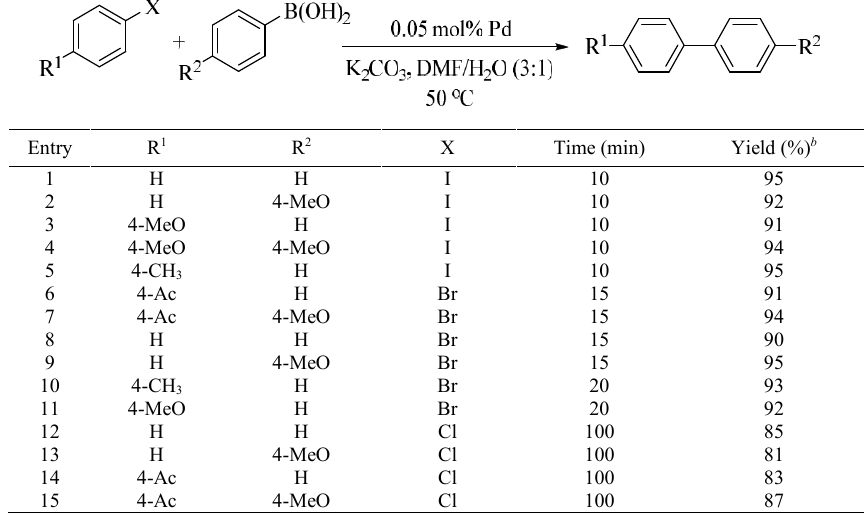
Table 2. Suzuki–Miyaura cross-coupling of aryl halides with arylboronic acid catalyzed by MNP/HPG-CA/Pd a